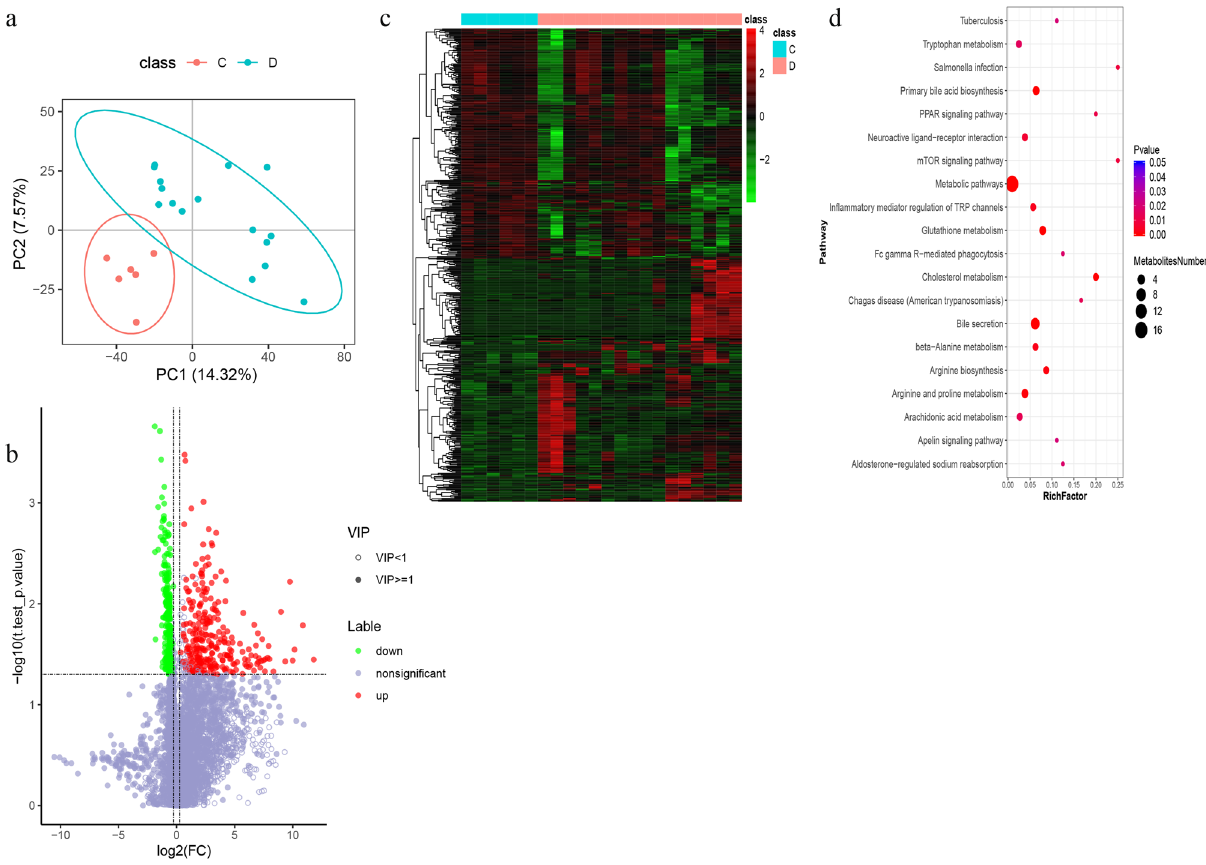
Figure 6. Positive differentially expressed metabolites were identified and analyzed using proteomics in Covid- 19 patients with progressive pulmonary fibrosis. ( a ) PLS-DA model plot for positive ion mode. ( b ) Volcano plots of positive compounds. ( c ) Heatmap of different positive metabolites (“pheatmap” package in R software v3.5.0, https:// www.r- proje ct. org/). ( d ) Bubble plot of the top 20 KEGG enrichment of positive metabolic pathways. C, Nonprogressive pulmonary fibrosis of Covid-19 patients. D, Progressive pulmonary fibrosis of Covid-19 patients. RichFactor is defined as the number of differential metabolites annotated to the pathway divided by all identified metabolites annotated to the